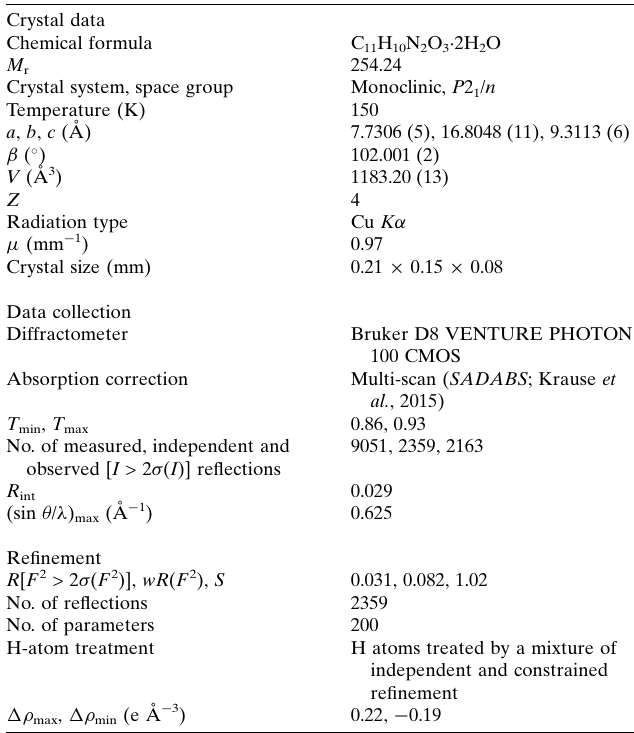
Table 2 Experimental